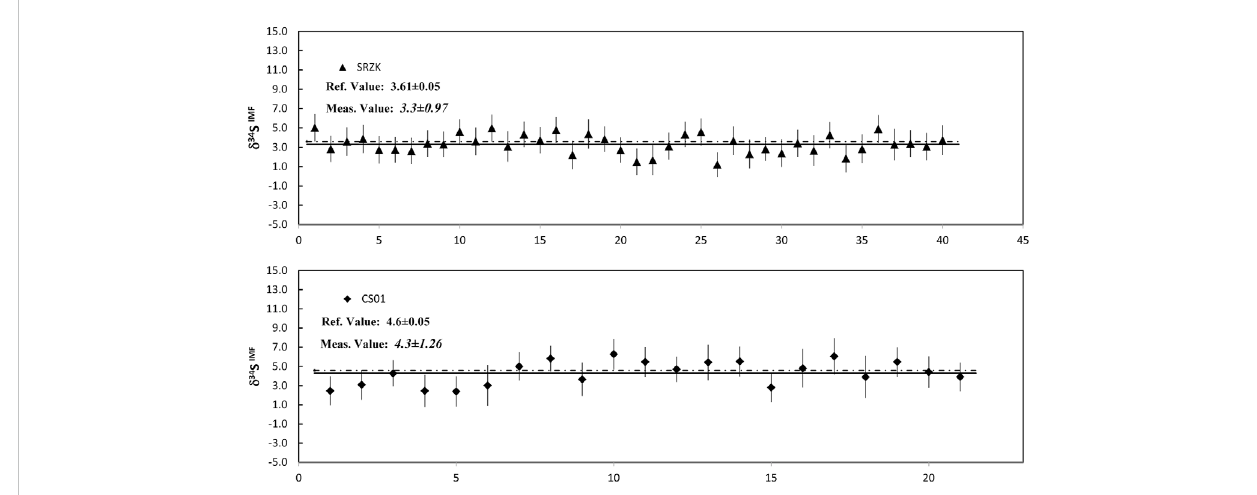
FIGURE 11 The plot of measured δ 34S on PY-SRZK with the ROIs of 1.5 μ m 2 and the PY-CS01 with the ROIs of 2.5 μ m 2